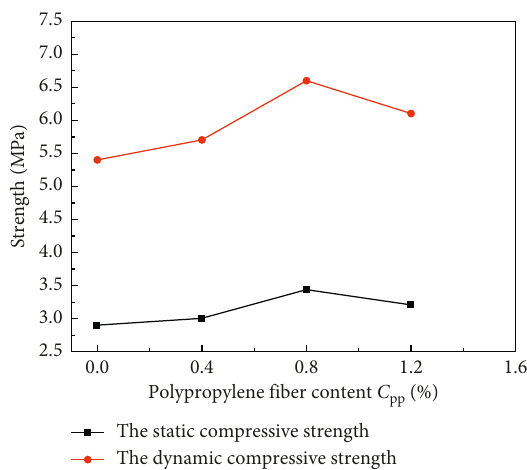
Figure 5: The dynamic and static compressive strength of cement soil with different polypropylene fiber